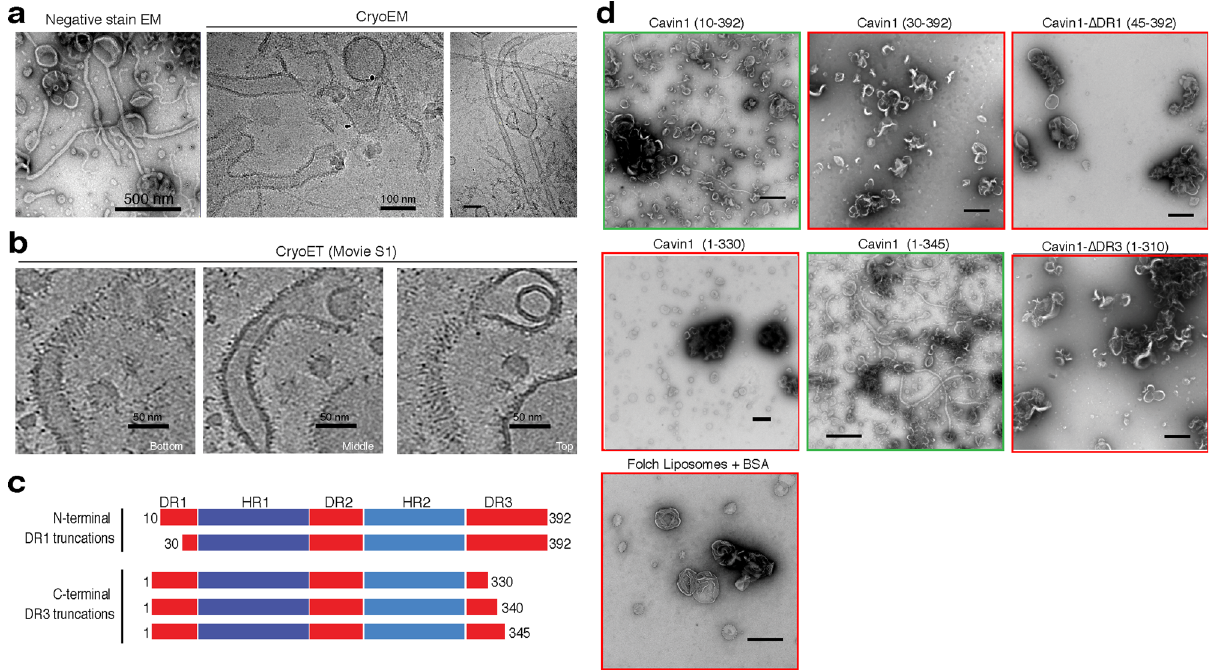
Fig. 4 The Cavin1 DR domains are required for membrane remodelling in vitro. a Puri fi ed Ub-tagged full length Cavin1 was mixed with Folch 400 nm unilamellar liposomes and analysed by both negative stain EM (1% uranyl acetate) and cryoEM. b Cryoelectron tomography (CryoET) of Cavin1-coated membrane tubules showing bottom, middle and top sections of three-dimensional projections. Striated protein densities are observed coating the relatively heterogeneous membrane tubules. The full tomogram is shown in Supplementary movie 1. c Schematic diagram of Cavin1 and different truncation constructs examined for their ability to remodel membranes in vitro. d Puri fi ed Ub-tagged Cavin1 truncations were mixed with Folch 400 nm unilamellar liposomes and analysed by negative stain EM (1% uranyl acetate). Full membrane tubulation and remodelling activity requires residues 1 – 30 in DR1, and residues 330 – 345 in DR3. Scale bar = 500